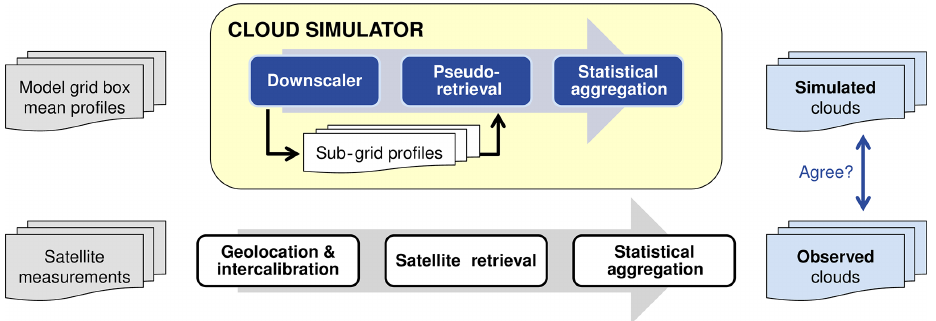
Figure 1. Schematic representation of the basic principle of the SIMFERA satellite simulator, which in many aspects is common to other satellite simulators. SIMFERA is a diagnostic tool that maps the model representation of clouds to synthetic satellite